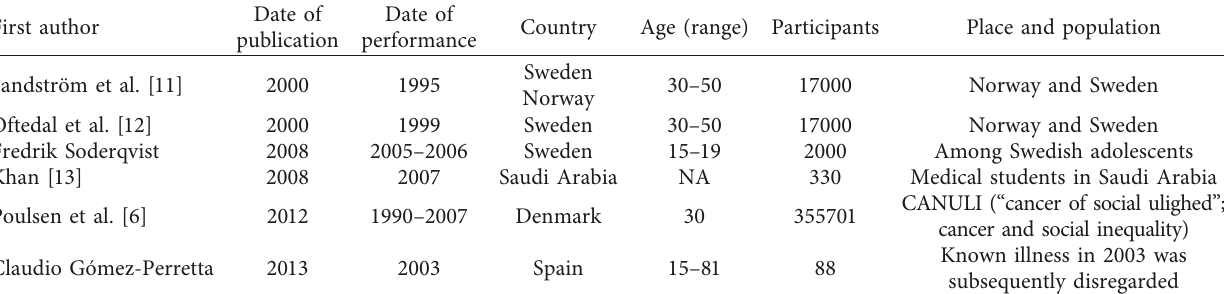
Table 1: Studies on the effects of mobile on skin